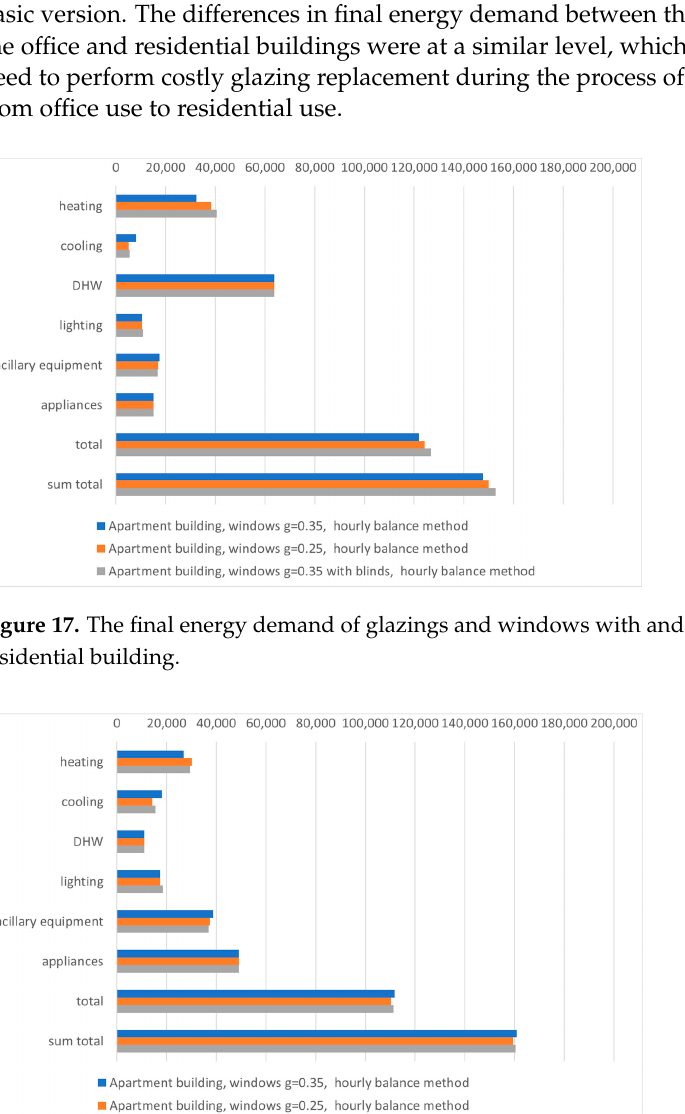
Figure 18. The final energy demand of glazings and windows with and without solar blinds for the office building.